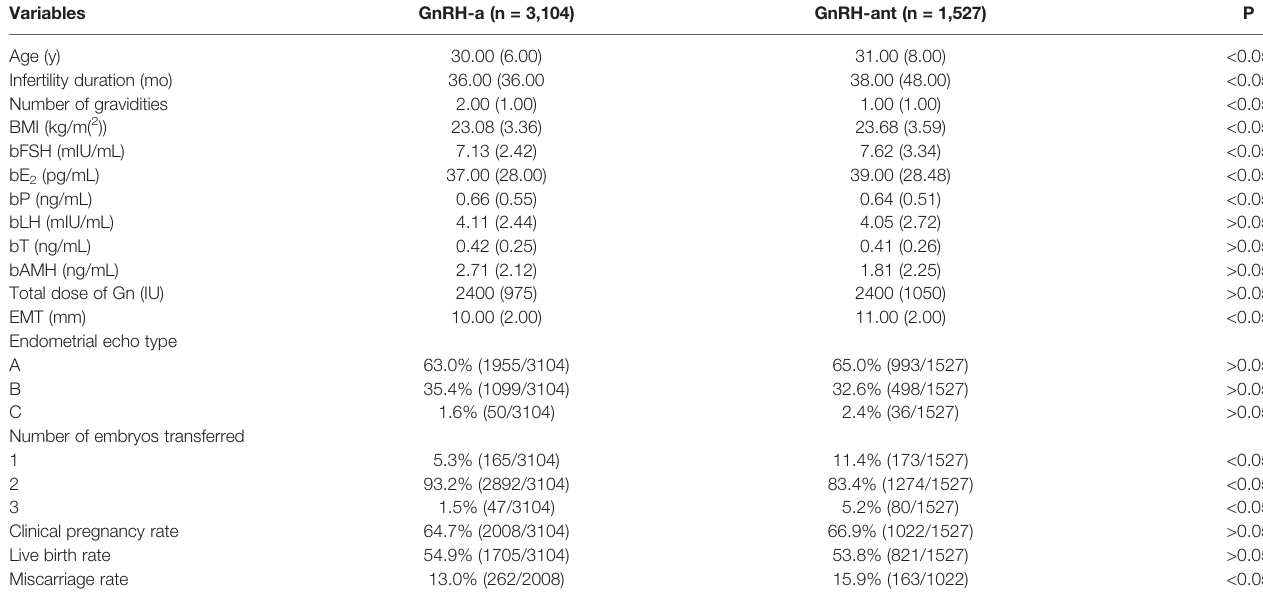
TABLE 1 | Clinical data and pregnancy outcomes in different